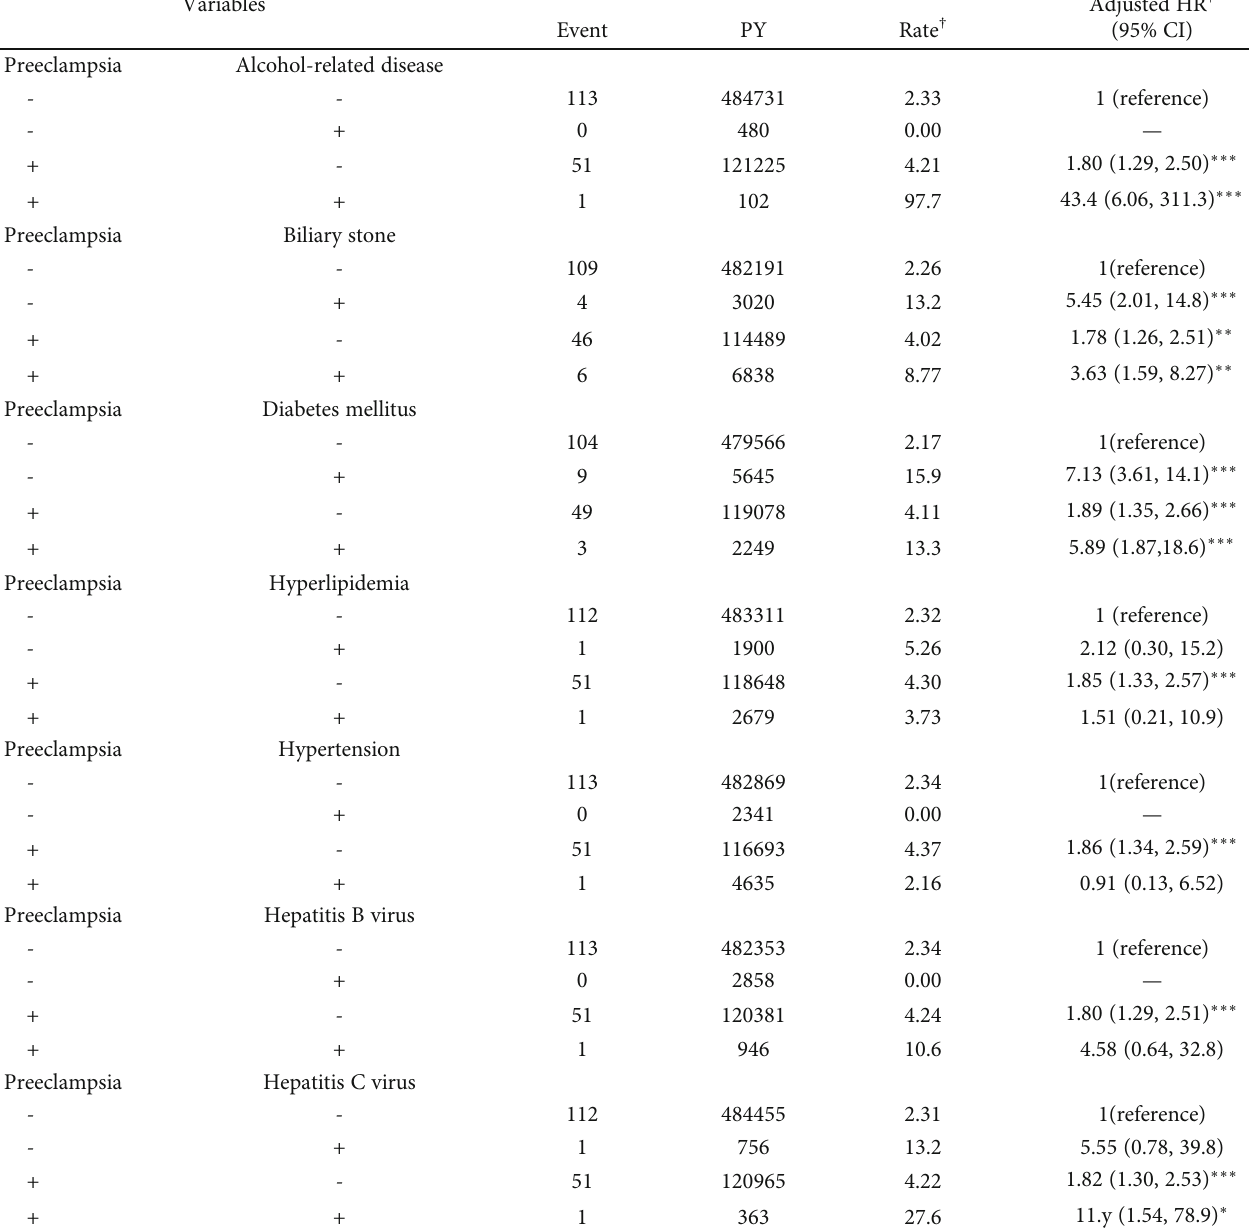
Table 3: Cox proportional model to measure the pancreatitis hazard ratio in patients with or without